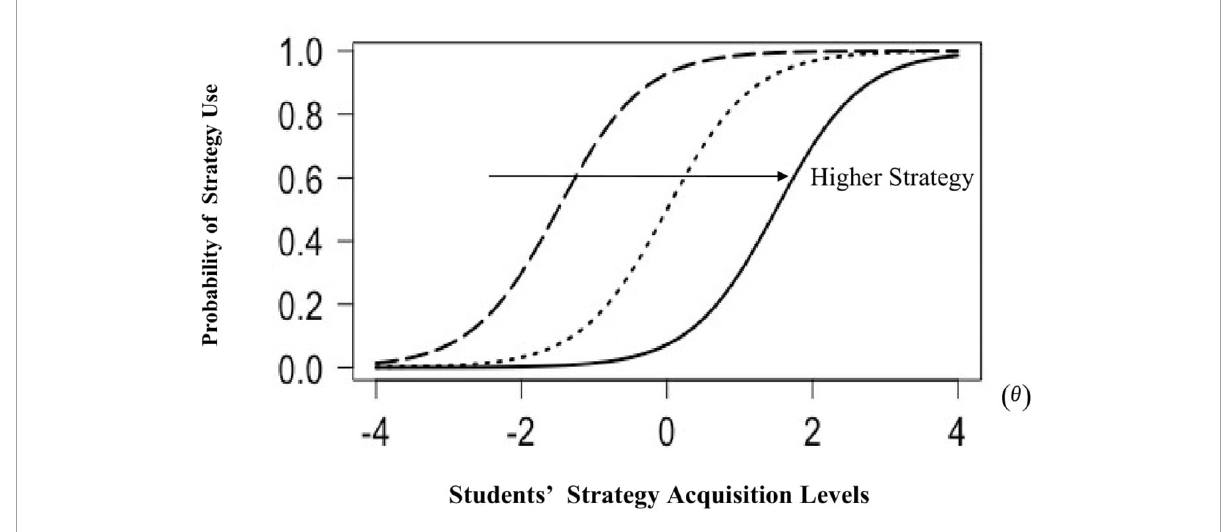
FIGURE1 Basic framework and